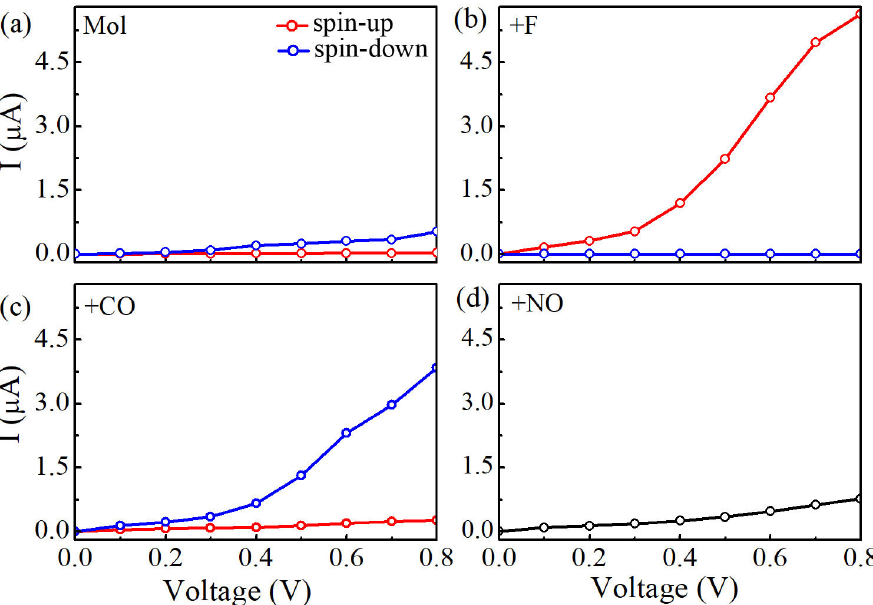
Figure 3. ( a ) Calculated currents of Mn-salophen molecular junction as a function of the applied bias voltage, ( b – d ) The I-V curves of Mn-salophen molecular junction with F, CO, and NO adsorptions. Here, the red and blue lines stand for the spin-up and spin-down electrons,